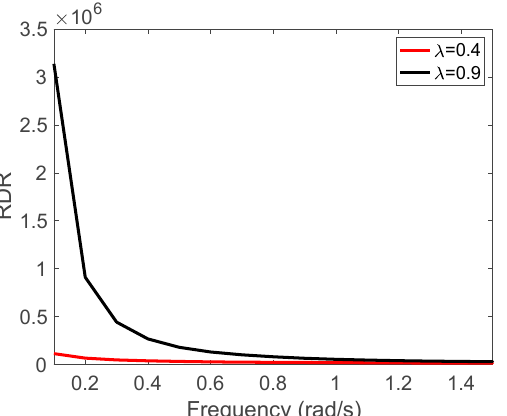
Figure 3. RDR values corresponding to two different FO-PI controllers.